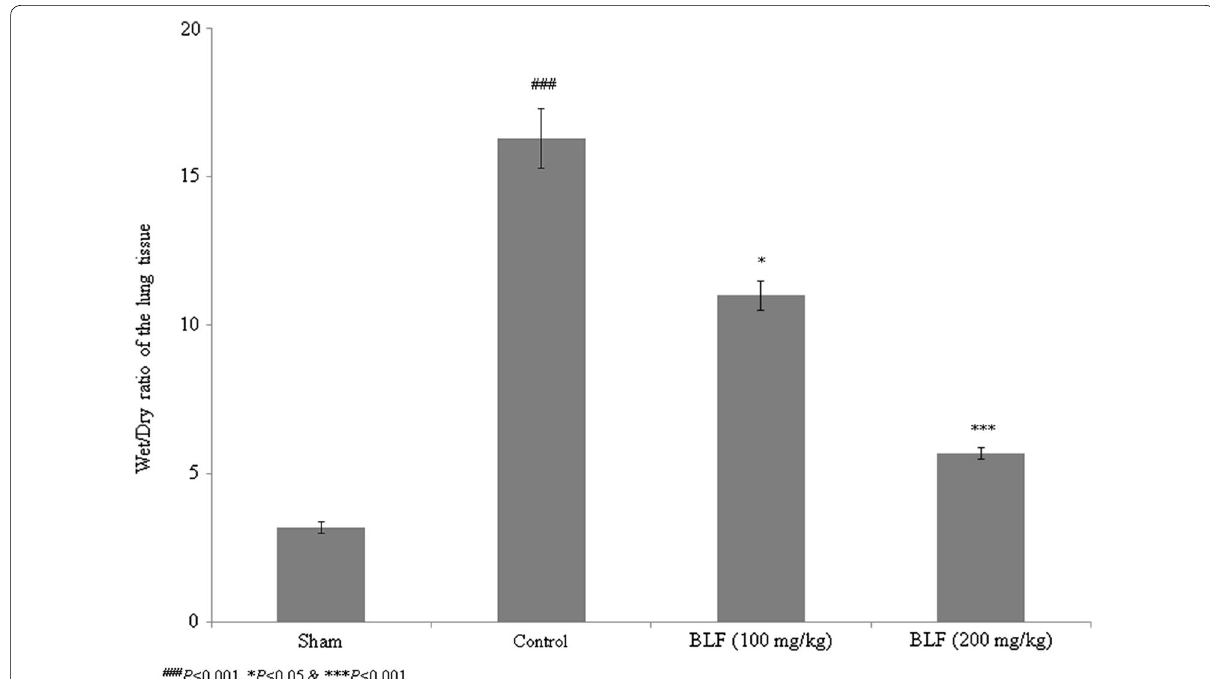
Fig. 1 Bovine lactoferrin (BLF) reduces the wet/dry ratio of lung tissue in acute lung injury (ALI)-induced male albino rats. Rats were given BLF for 30 consecutive days through oral gavage. ### P < 0.001 compared to the sham group; * P < 0.05 and *** P < 0.001 compared to control rats